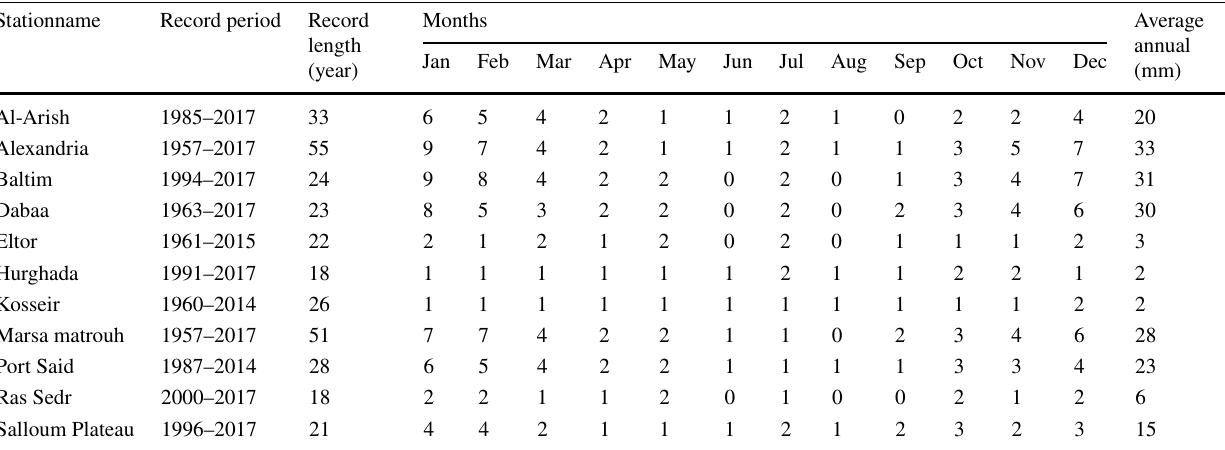
Fig. 4 Spatial distribution of mean annual precipitation in Egypt (Gado and El-Agha 2020) Table 2 Average monthly and annual rainy days in the Egyptian coastal cities (Gado and El-Agha